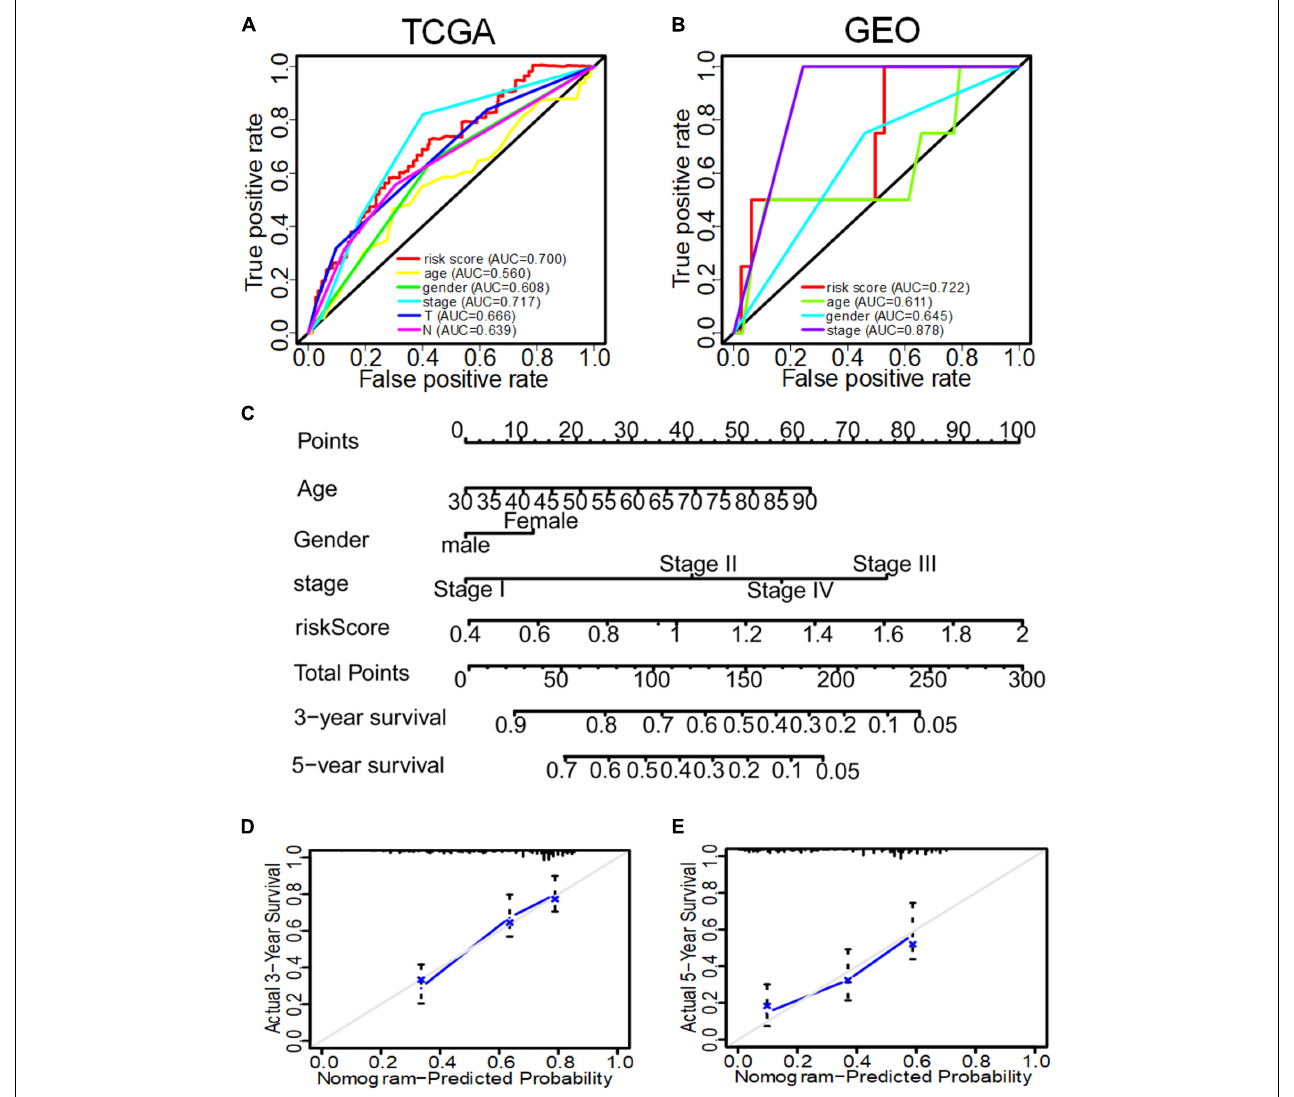
FIGURE 5 | The ROC curve of evaluating the reliability of each clinical feature to predict the prognosis of patients in TCGA and GEO in and the nomogram of 3–5-year OS predicted by the IRS of three immune genes combined with other clinical features. (A) The ROC curve of each clinical feature to predict the prognosis of patients in TCGA. (B) The ROC curve of each clinical feature to predict the prognosis of patients in GEO. (C) The nomogram to predict the 3-year and 5-year OS of patients in TCGA. (D) The correction nomogram of predicting the 3-year OS of patients. (E) The correction nomogram of predicting the 5-year OS of patients.